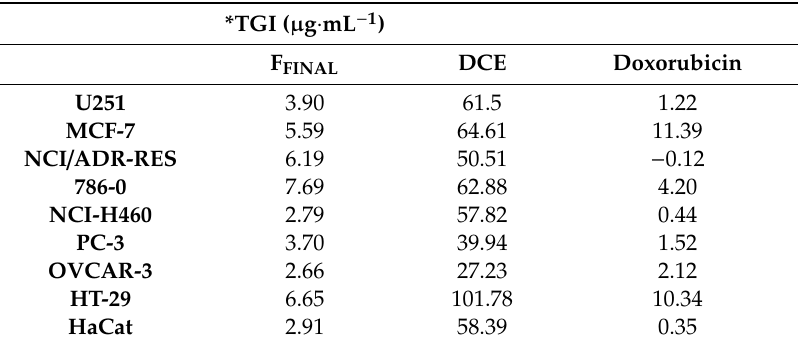
Table 3. Anti-proliferative activity of F FINAL , dichloromethanic crude extract (DCE) and doxorubicin, against human cancer cell lines and one none tumor cell line.